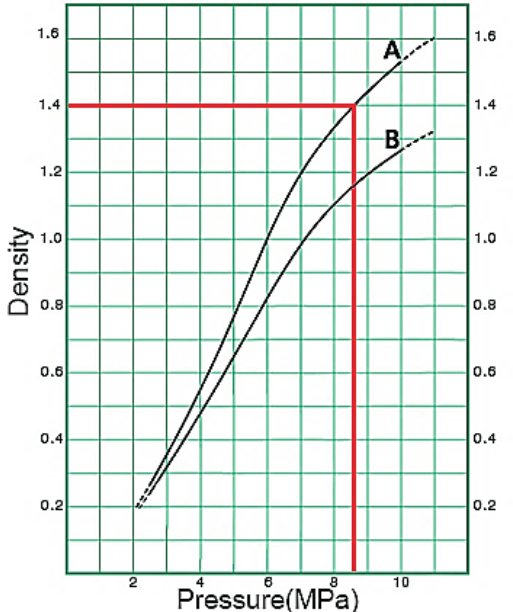
Fig. 3. Graph used for the determination of values of bite pres- sure.